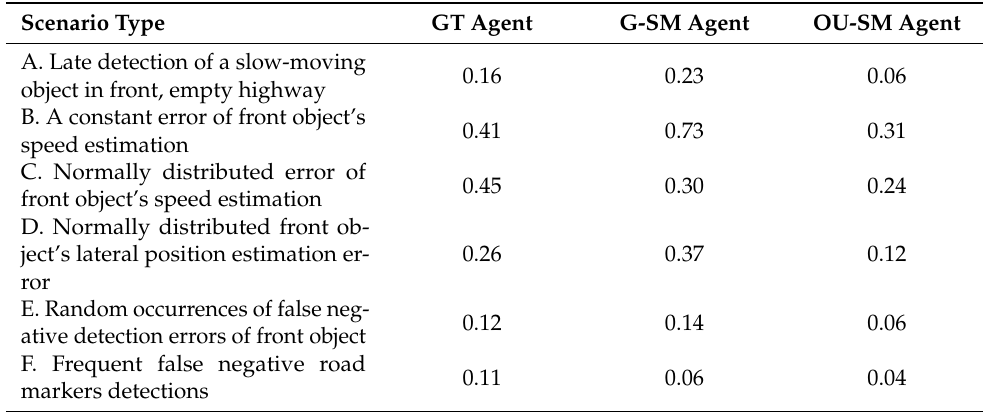
Table 2. Performance of the agents in test scenarios. Each agent was evaluated in each scenario type 100 times, where scenarios for each run were sampled from the distributions described in Appendix B. Performance in the table is measured by a fraction of sampled scenarios evaluations that ended in collisions (the lower the